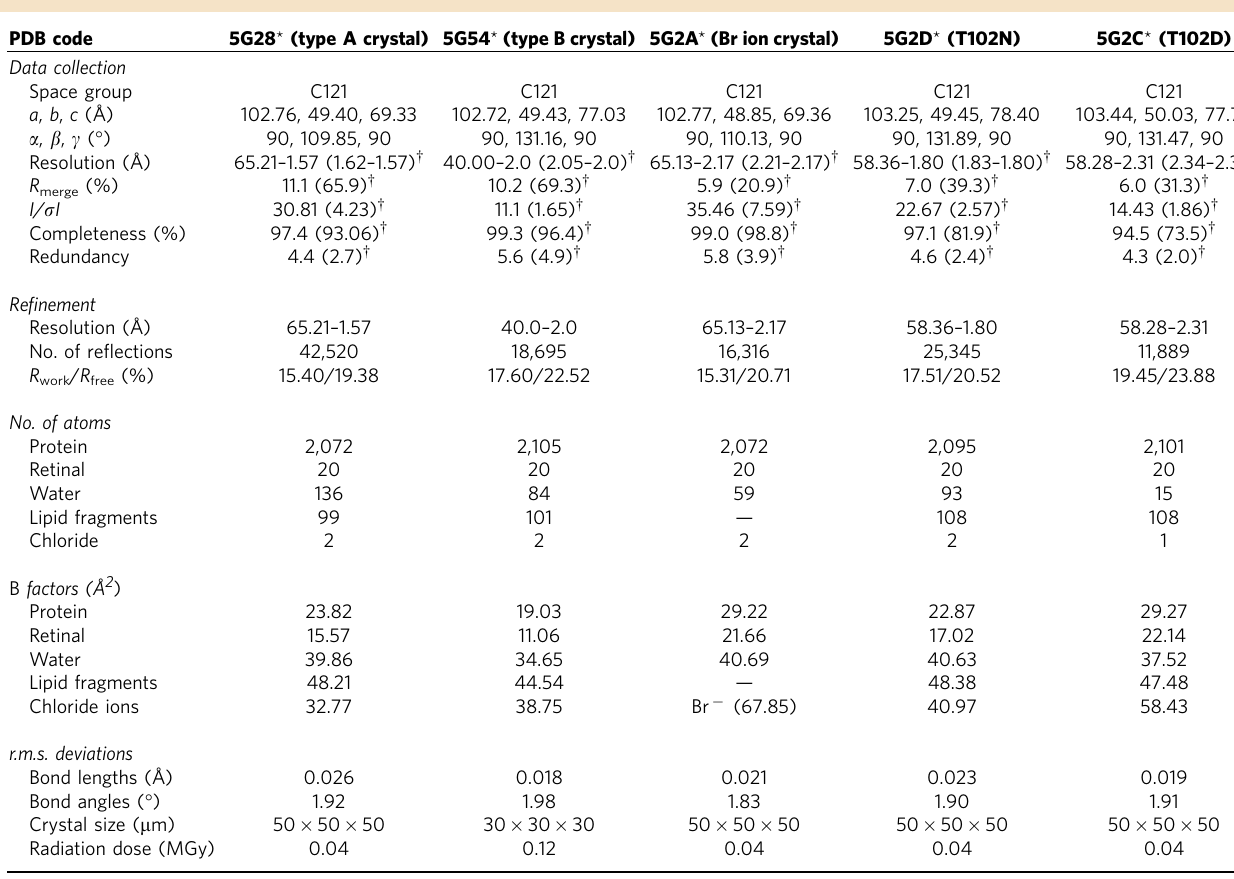
Table 1 | Data collection and refinement